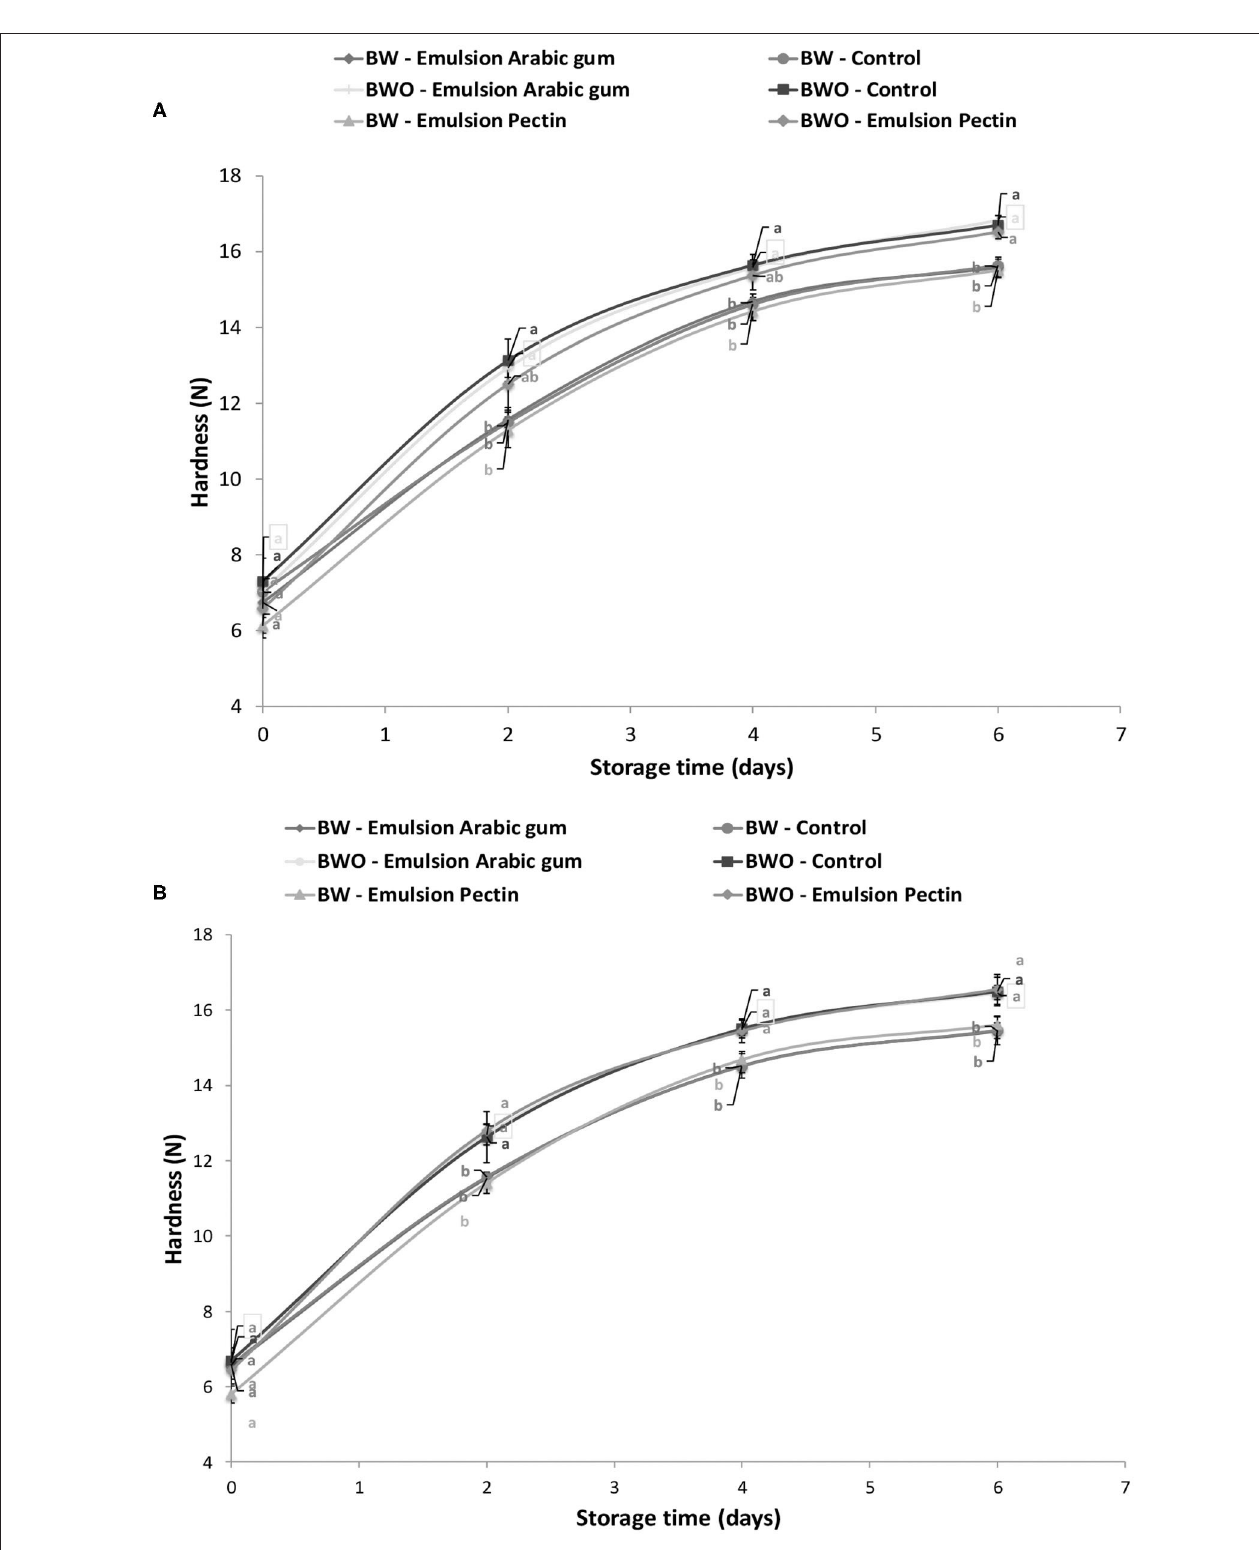
FIGURE 5 | Hardness of two bagel formulations, bagel-wheat flour (BW) and bagel-wheat flour-oats (BWO), atomized with emulsions stabilized with pectin or Arabic gum at 10% w/w (A) and 15% w/w (B) of Mexican oregano essential oil (MOEO) during 6 days of observation, stored at 25 ◦ C. Systems that do not share the same letter at each time are significantly different ( p <